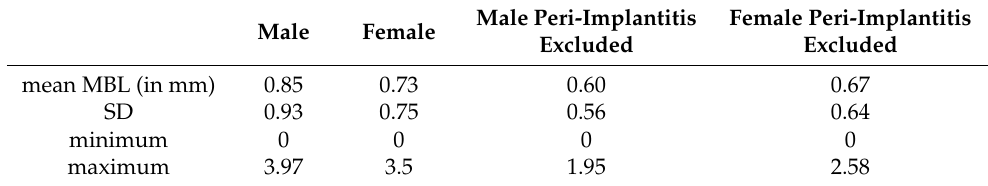
Table 3. Marginal bone loss (MBL) in age groups. Data are means ± SD.